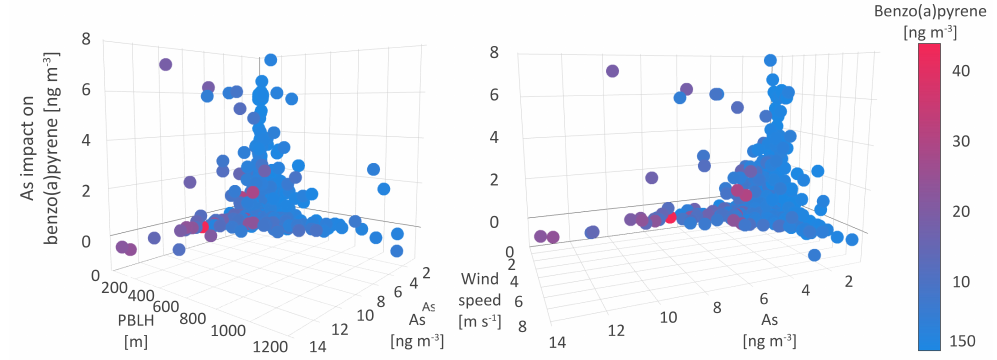
Figure 8. Arsenic impact on